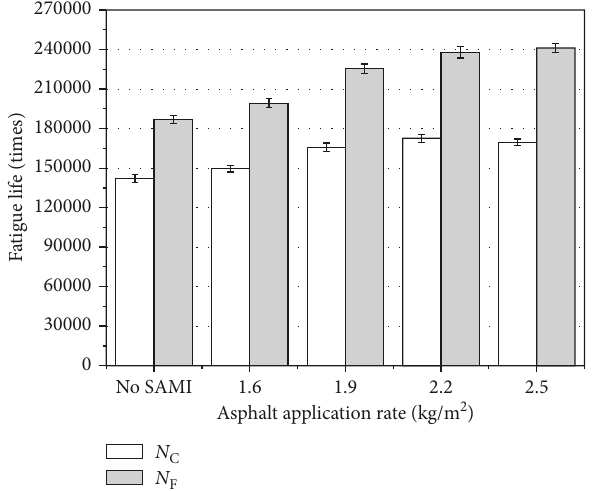
Figure 12: Fatigue cracking test results under the condition of dry and water bath at 15 °